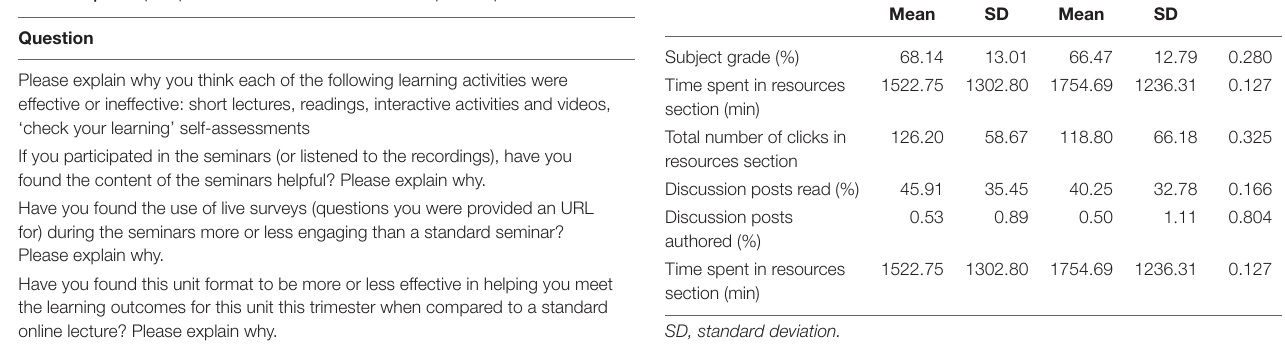
TABLE 2 | Example questions used in the extended response questionnaire.